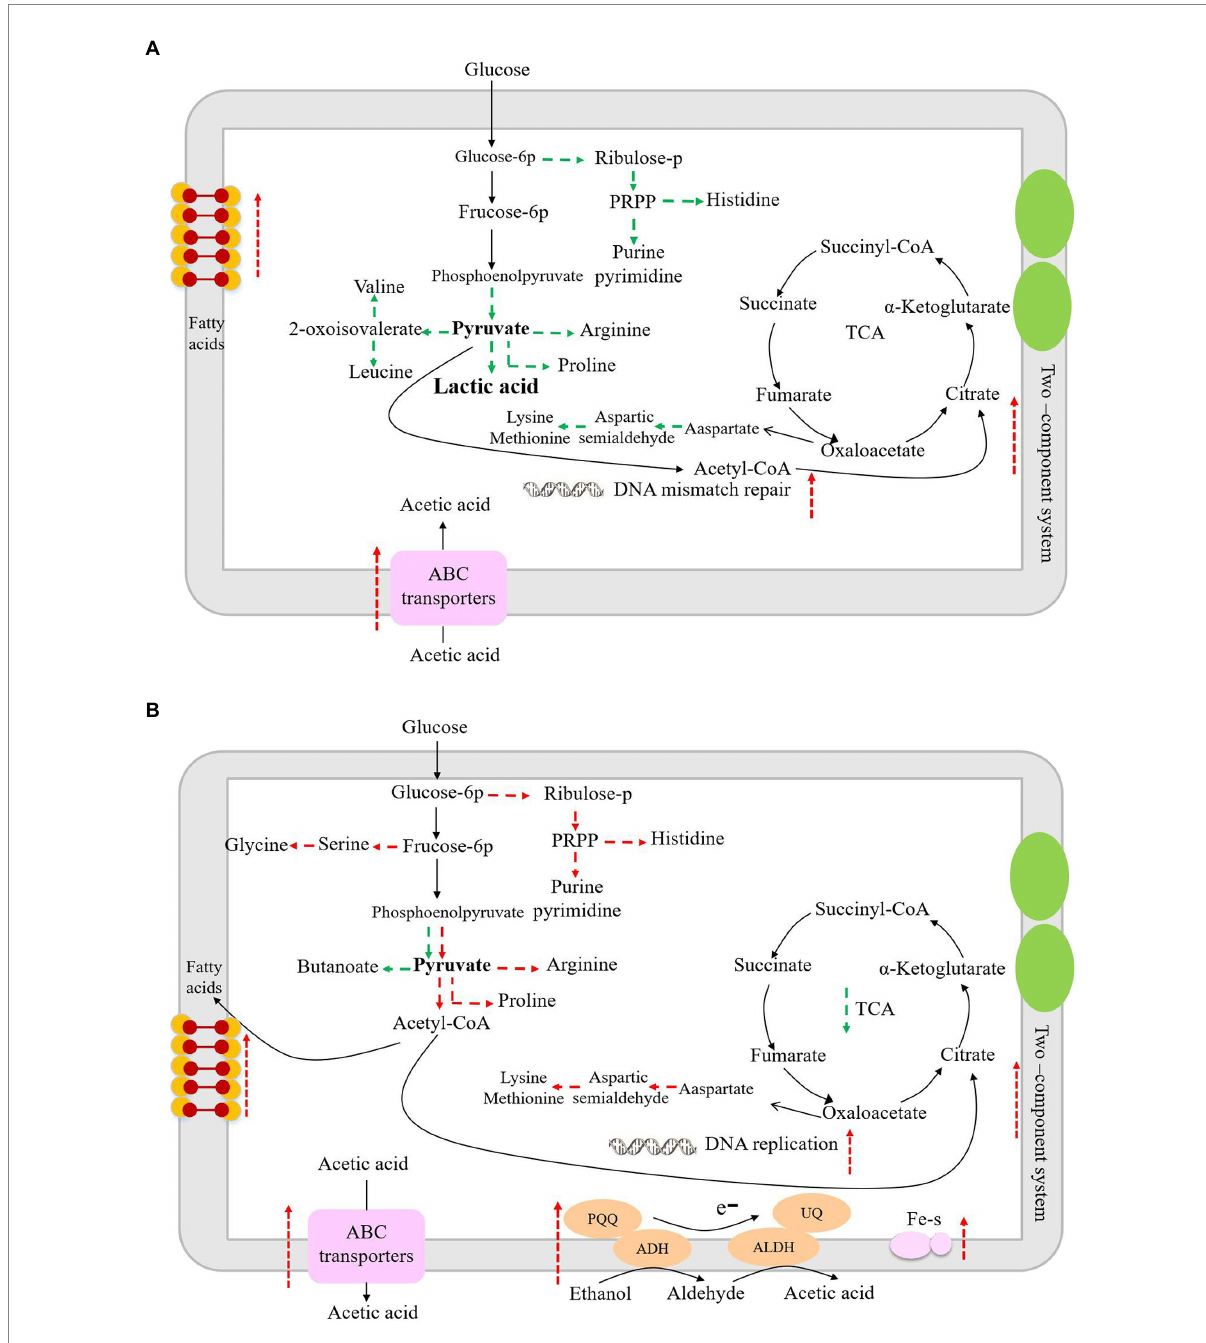
FIGURE 6 The sketch map of metabolism changes in L. helveticus CGMCC 12062 (A) and A. pasteurianus CGMCC 3089 (B) under coculture condition compared with that of mono-culture. Red represents up-regulation of metabolic pathway or gene transcription, and green represents down-